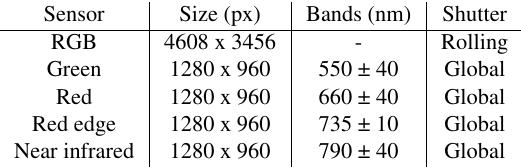
Table 1: Multispectral sequoia camera (Parrot) sensors specifica- tions.